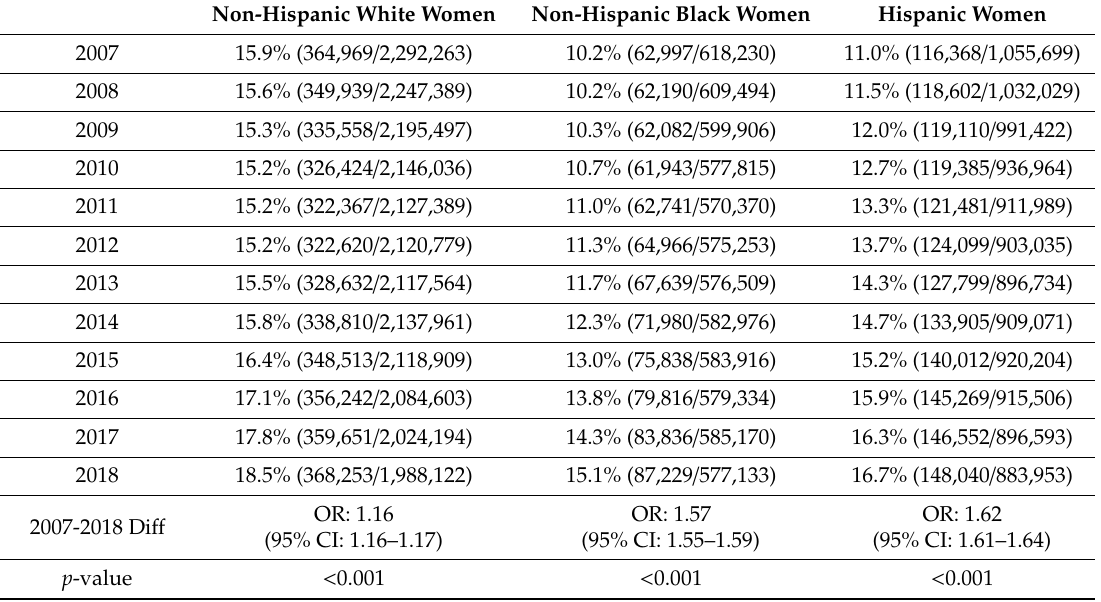
Table 4. Annual prevalence of advanced maternal age (AMA) for 2007–2018, by racial / ethnic